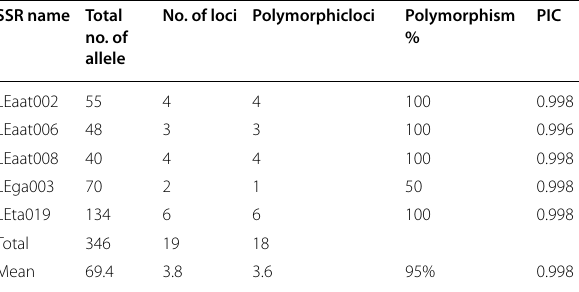
Table 3 SSRs name, total number of alleles, number of loci, polymorphic loci, percentage of polymorphism, and polymorphism information content (PIC)